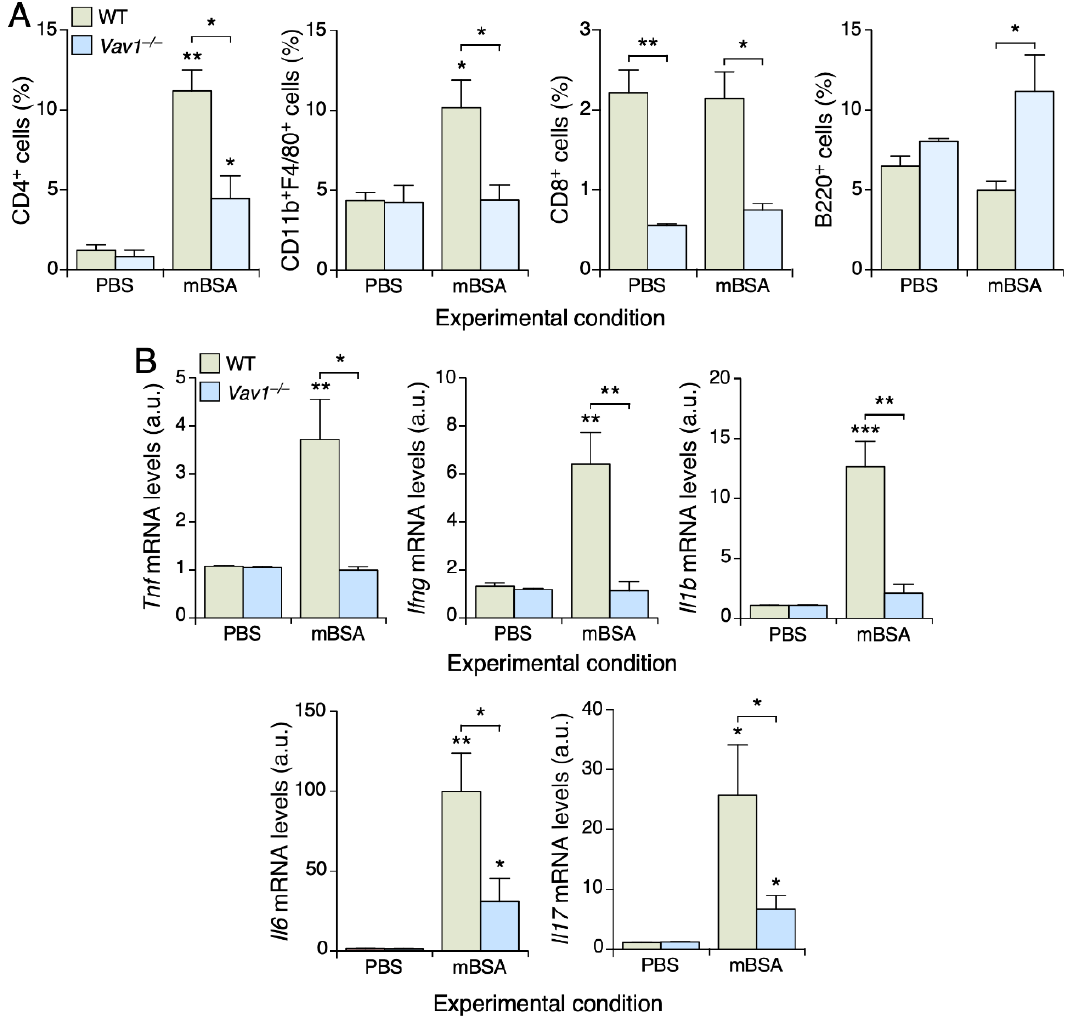
Figure 2. The Vav1 deficiency impairs the infiltration of CD4 + T cells and macrophages in mBSA-treated joints. ( A ) Deter- mination by flow cytometry of the infiltration levels of indicated cell types in placebo- and mBSA-injected knee joints of mice of the indicated genotypes. PBS, phosphate-buffered saline solution. ( B ) Levels of indicated transcripts in the knee joints from mice of indicated genotypes (inset) and under the specified experimental conditions (bottom). Values are shown relative to the abundance of each transcript in the placebo-injected WT samples, which were given an arbitrary number (a.u.) of 1. Data shown in panels A and B represent the mean ± SEM. *, p ≤ 0.05; **, p ≤ 0.01; ***, p ≤ 0.001 relative to either placebo-injected joint of animals of the same genotype or relative to the respective WT control (in brackets). n = 4 in each experimental condition.